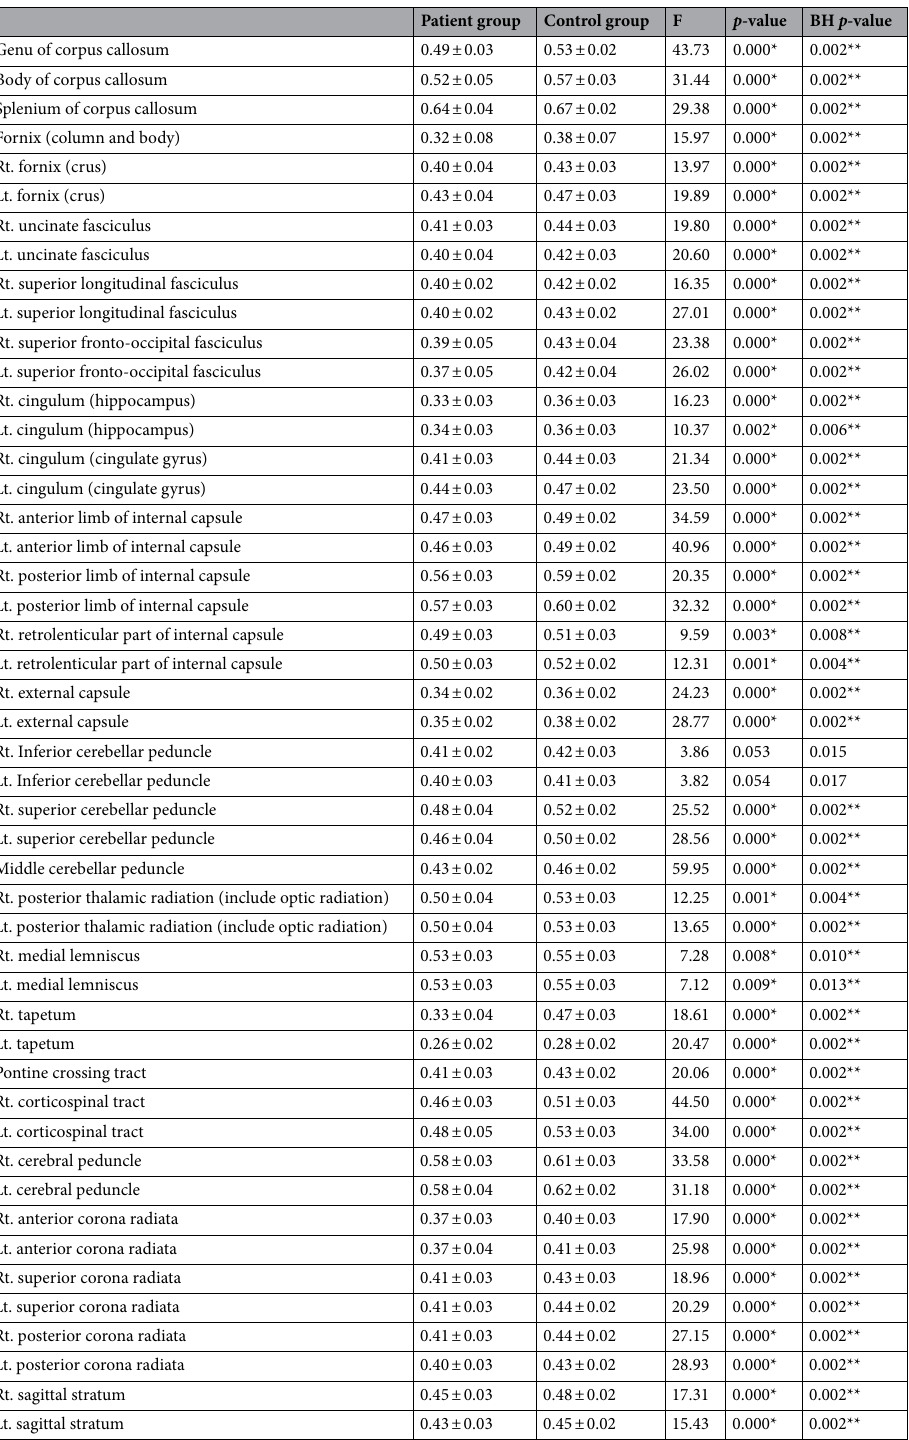
Table 2. Comparison of the fractional anisotropy values of brain regions between the patient and control groups. *Significant differences between the patient and control groups; patient group < control group, p < 0.05. **Significant differences between the patient and control groups using a Benjamini–Hochberg (BH) correction; Values are means ± standard